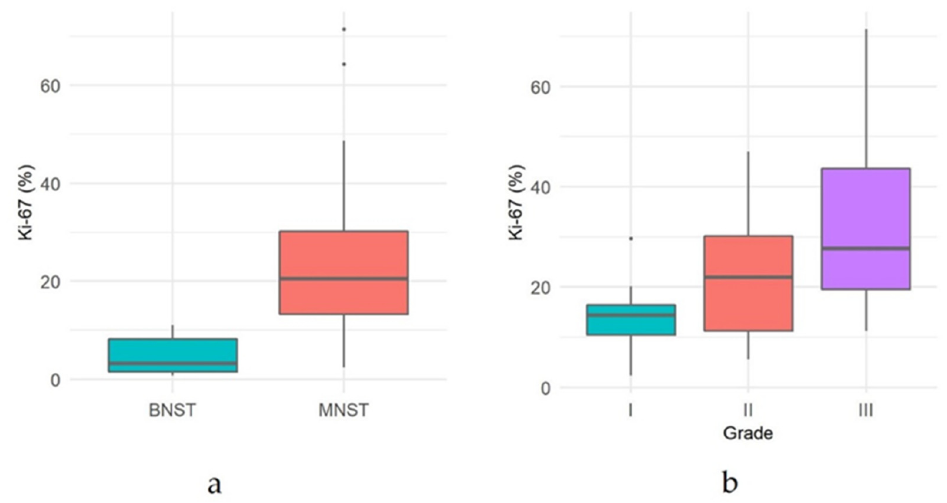
Figure 6. ( a ) Comparison of proliferation index Ki-67 between malignant nerve sheath tumors (MNSTs) and benign nerve sheath tumors (BNSTs). ( b ) Comparison of proliferation index Ki-67 between different grades of malignant nerve sheath tumors.